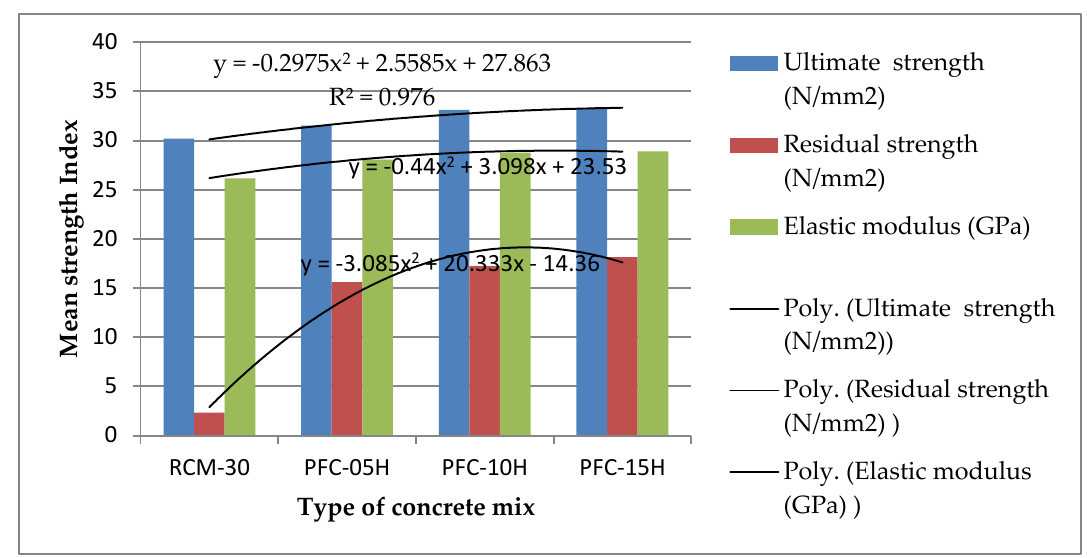
Figure 7. Characteristic compressive strength results of various plastic fiber concrete mixes.